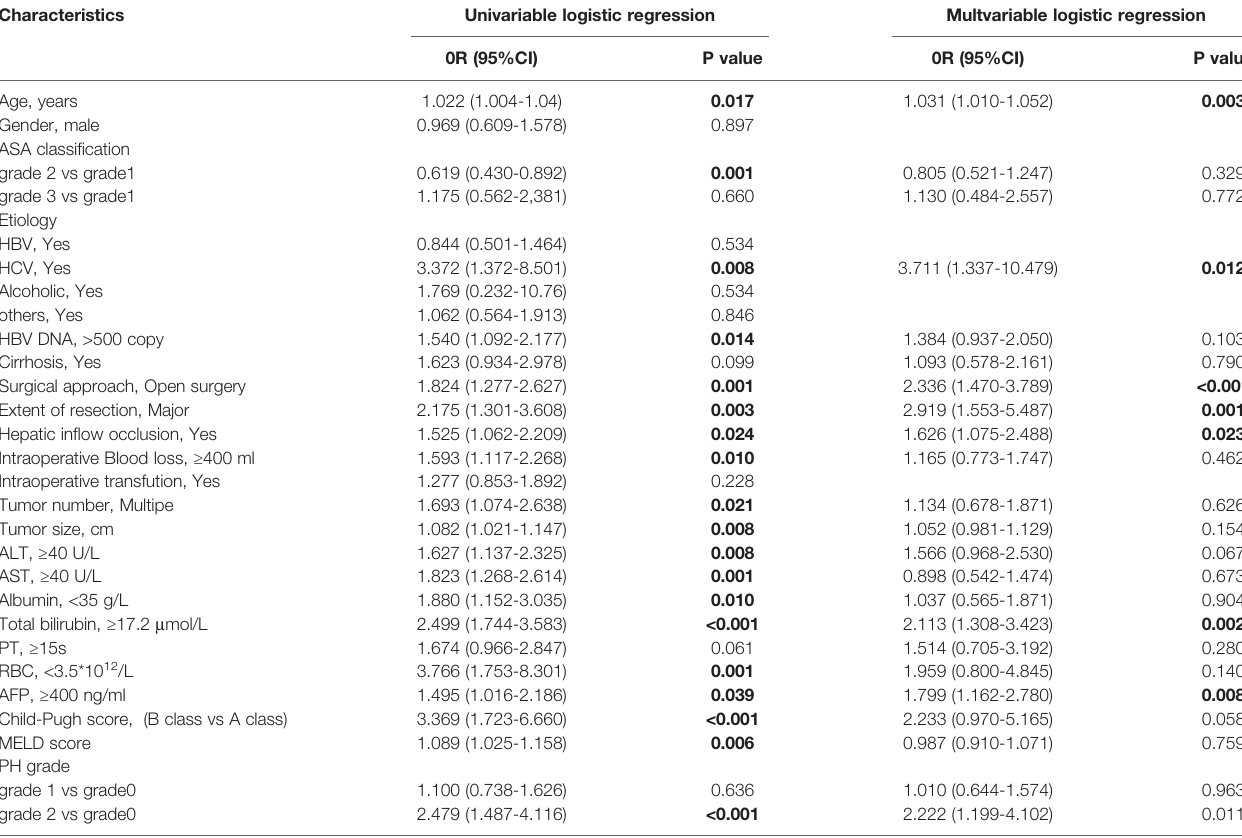
TABLE 2 | Factors Associated with Post Hepatectomy Liver Failure at Univariate and Multivariate Logistic Regression Analyses. Characteristics